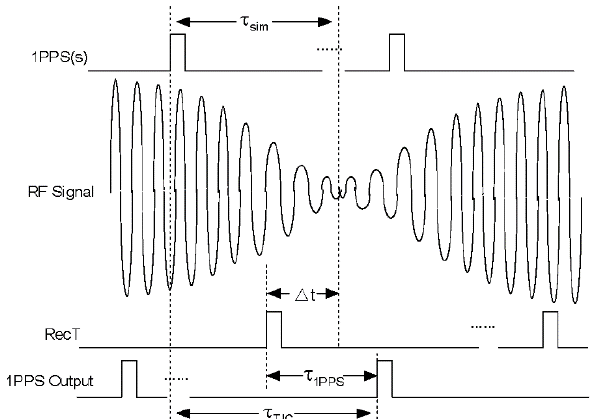
Figure 4. Calibration method of pulse-per-second (PPS) output delay.